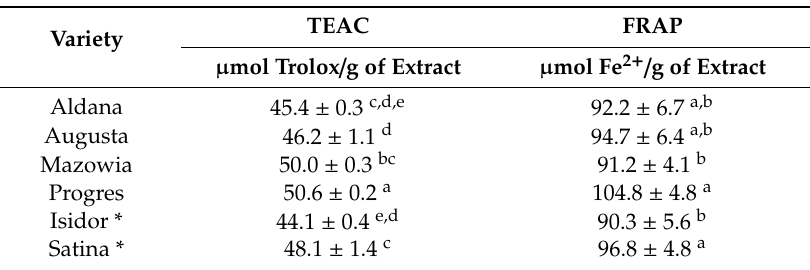
Table 2. Trolox equivalent antioxidant capacity (TEAC) and ferric-reducing antioxidant power (FRAP) in soybean seed extracts.